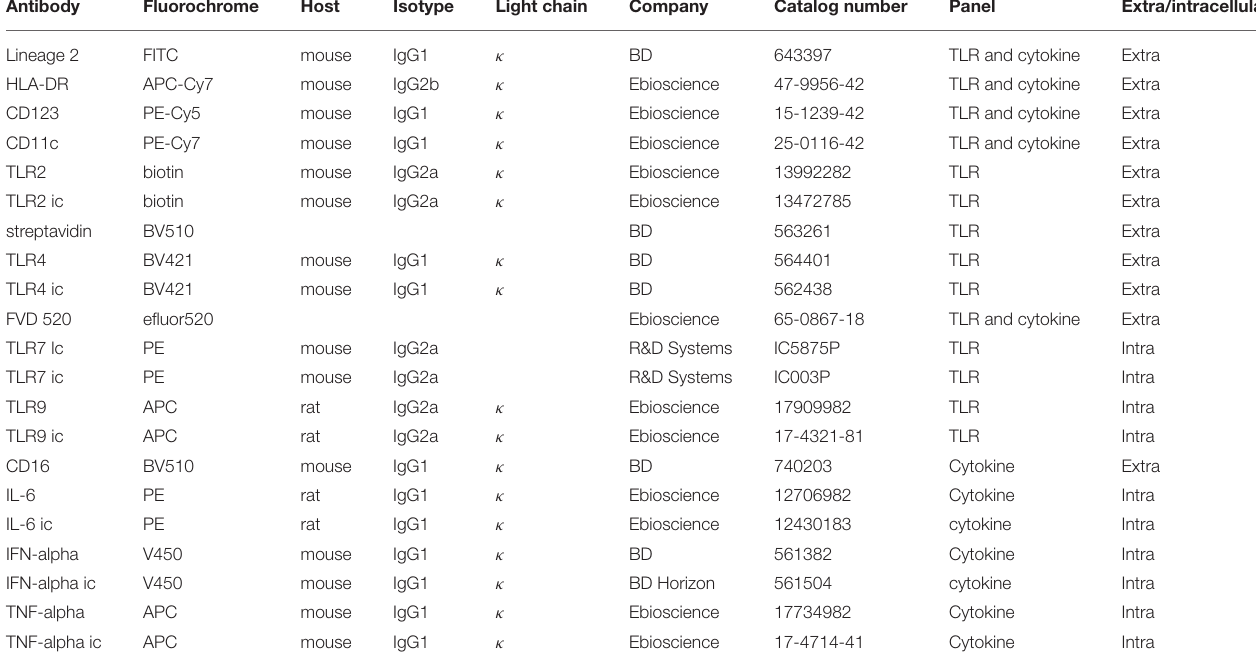
TABLE 2 | Antibodies used for TLR expression and intracellular cytokine measurements. Antibody Fluorochrome Host Isotype Light chain Company Catalog number Panel Extra/intracellular Lineage